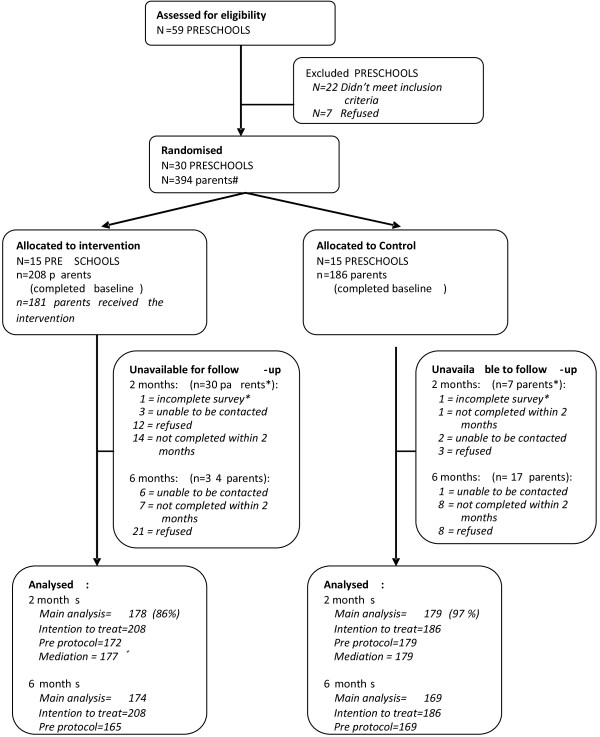
Consort diagram describing participant flow through the trial. # Approximately 2200 parents were invited to participate, 418 consented and 178 refused to participate. Of the 418 consenting parents, 24 were not randomised because they were subsequently unable to be contacted (n=5), didn’t meet inclusion criteria (n=9), or refused to complete the baseline survey when contacted (n=10). 2 parents were excluded from the 2month analysis as they had been away from their child for the past 24 hours and/or past 7 days, and were unable to answer questions about their child’s non-core food consumption. +1 participant only partially completed the baseline survey. They completed the NCFI data, but mediator data was not collected, hence they were included in the main analysis, but not the mediation analysis.